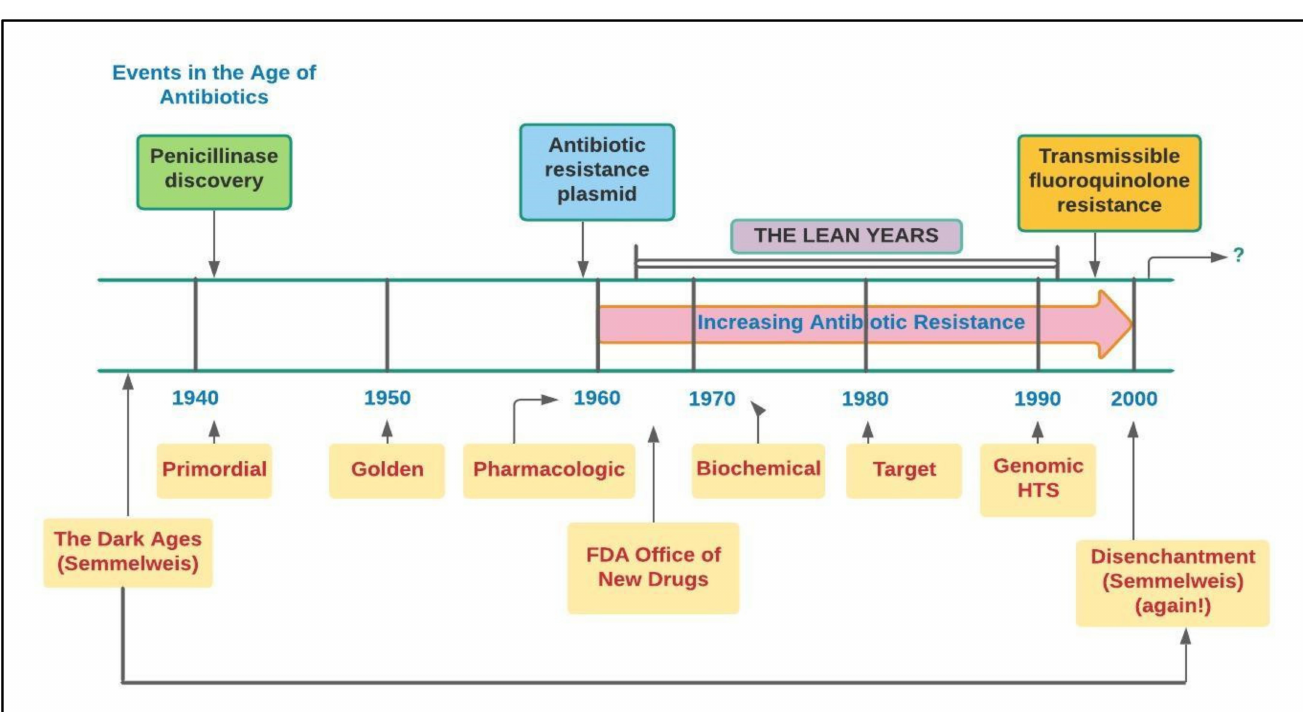
Figure 1. Background of discovery of antibiotics and the subsequent development of resistance to